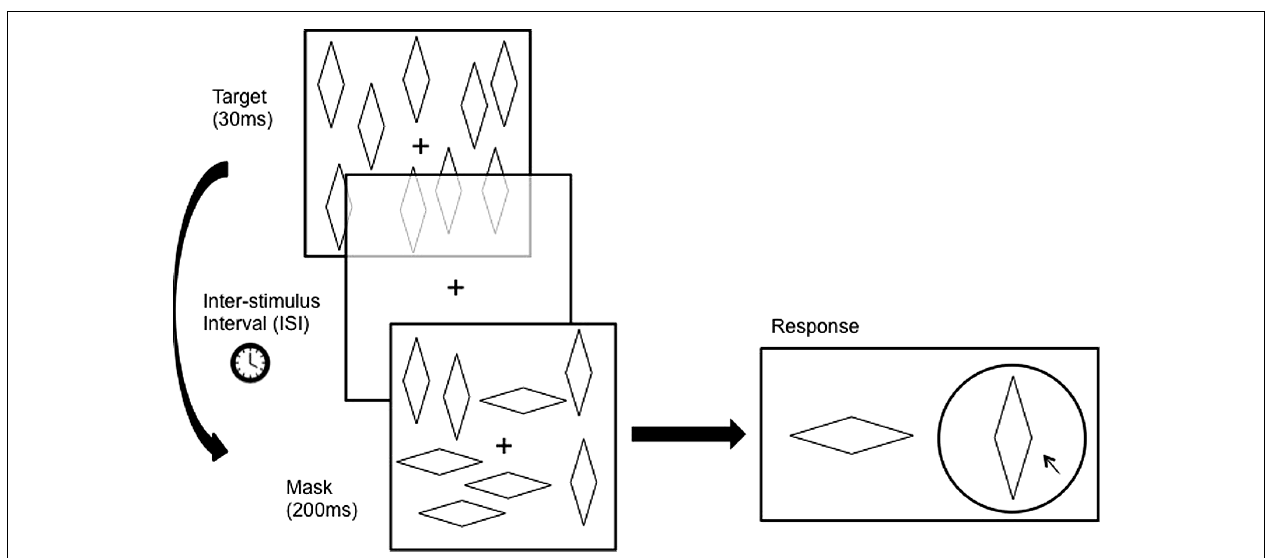
(D) Figures were arranged in an annular pattern around a central fixation point. The angle mask pattern is used as an example here. Only one configuration was shown as the target pattern (not shown), whereas a mixture of the two configurations was shown as the mask pattern, as in this example.